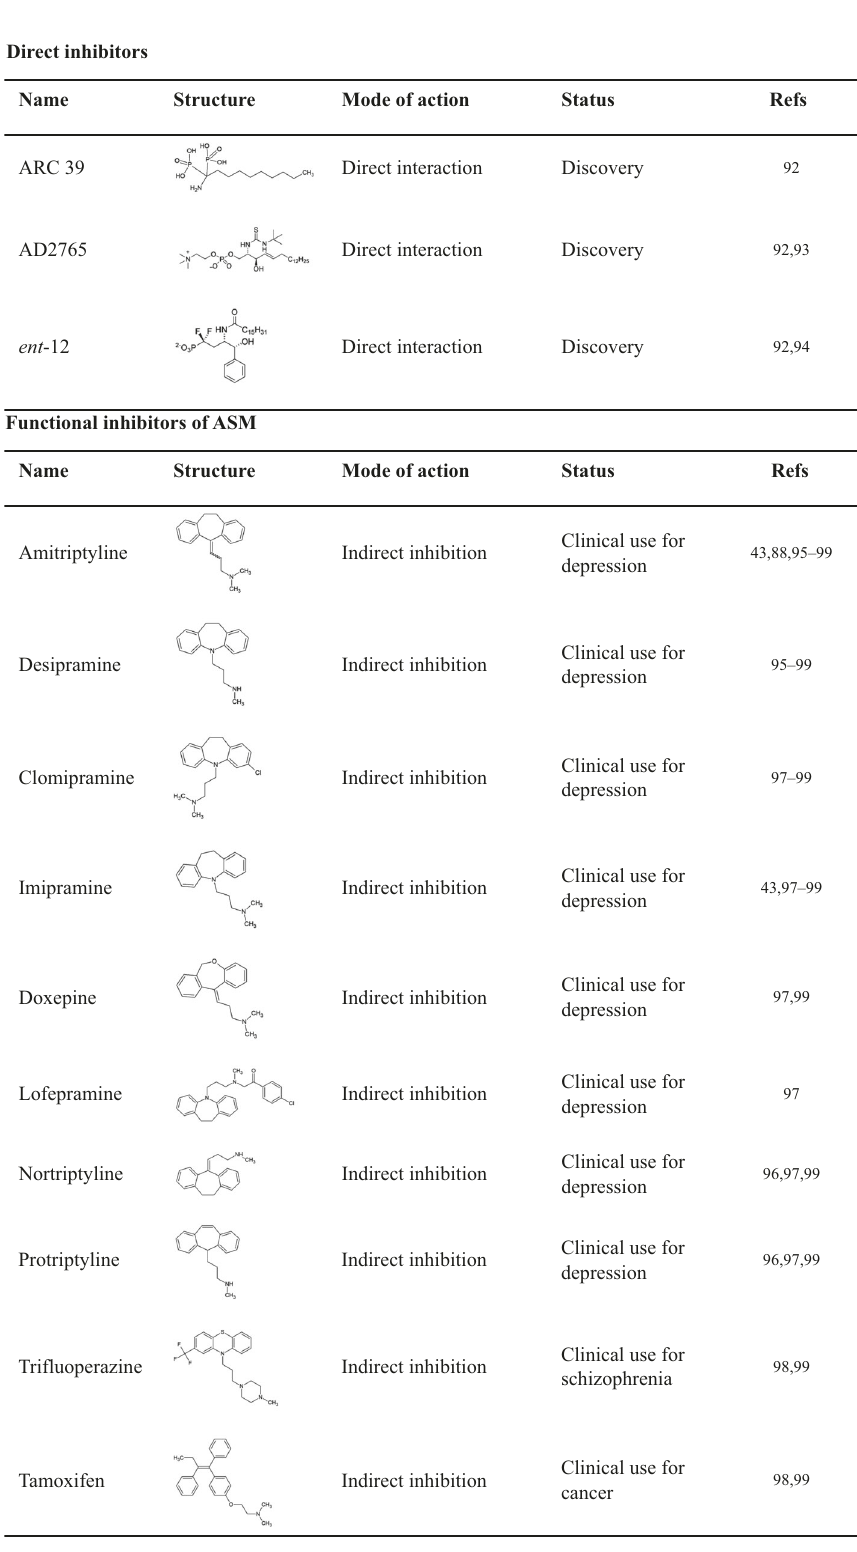
Table 2 Representative direct inhibitors and functional inhibitors of